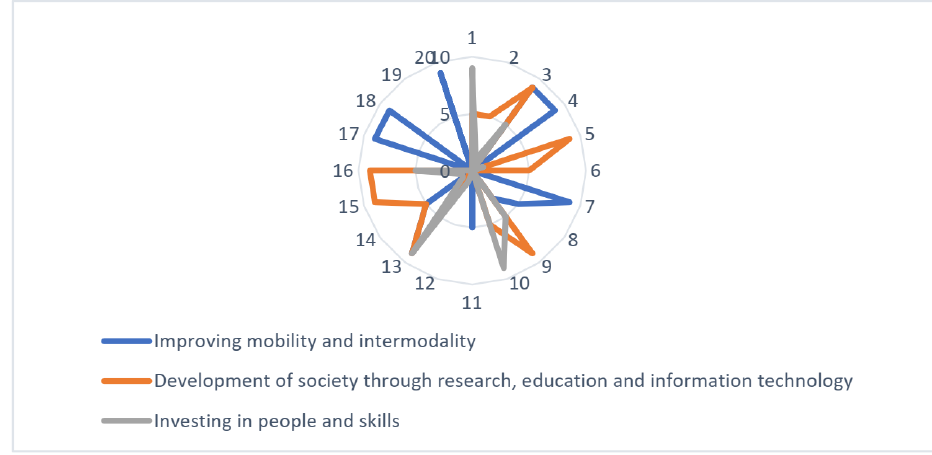
Figure 3. The relationship between technical measures taken by the European Commission.